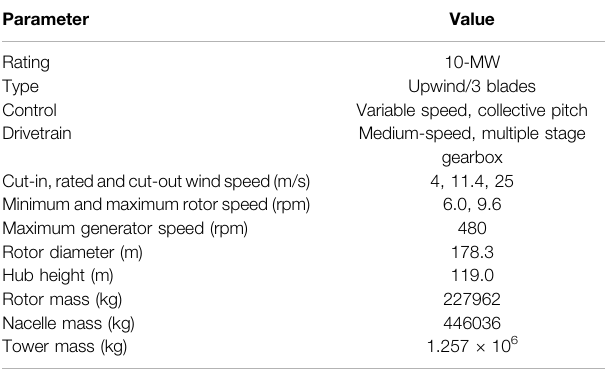
TABLE 1 | Key parameters of the DTU 10-MW reference wind turbine (Yu et al., 2017). Parameter